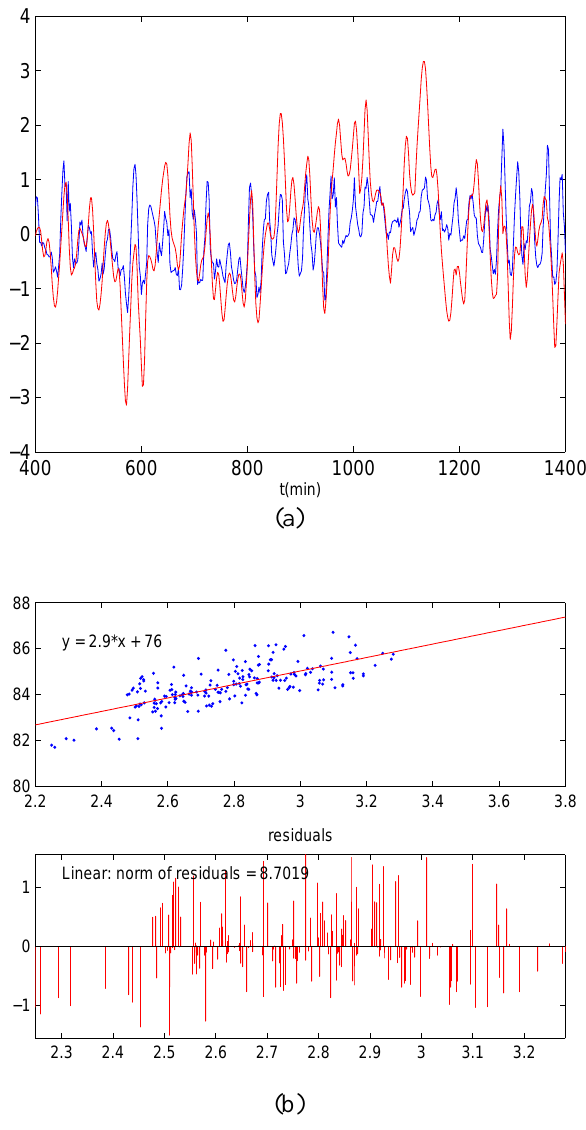
Fig. 14. Correlations of mixing rates for the BL inflow box (a) Fig. 15. (a) Normalized MMR for 20 minutes backward integration Fig. 15. (a) Normalized MMR for 20min backward integration and eyewall updraft box (b) lagged by t to maximal tangential time in eyewall updraaft (blue), and maximum tangential winds de- time in eyewall updraaft (blue), and maximum tangential winds de- winds with 20 min. backward integration time for FMR (red), FRD layed 10 minutes (red). (b) FRD for 20 minutes backward integra- layed 10min (red). (b) FRD for 20min backward integration time (black), and MMR (blue). Filled circles indicate correlation above a tion time against maximum tangential winds delayed 4 minutes for against maximum tangential winds delayed 4min for the BL inflow, 99% confidence threshold, while open circles indicate correlations the BL inflow, with linear best fit and norm of residuals. with linear best fit and norm of above 95% but below 99% confidence.